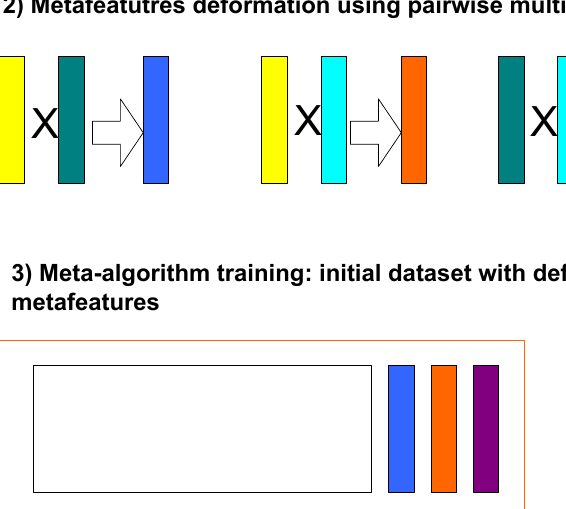
Figure 3. The stacking schema. On ox -axis, we have different colored columns: yellow, green and blue columns indicate the results made by weak predictors, dark blue, orange, violet columns indicate the results of pairwise multiplication. The realization of the new proposed stacking ensemble is given below.